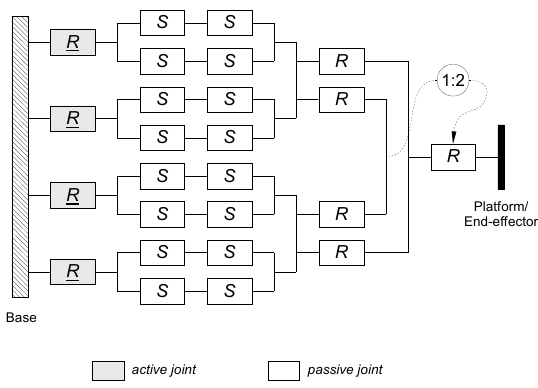
Figure 3. Kinematic diagram of the mechanism of delta 4-DoF robot.